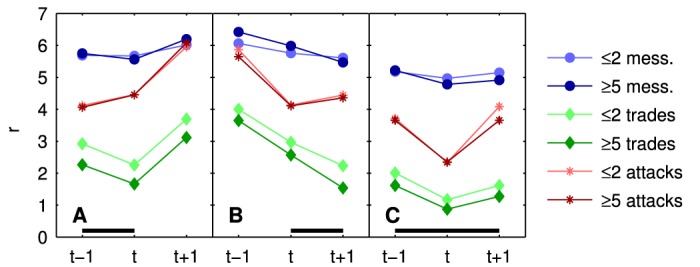
Relative distance r
β of players before and after interactions.The black line indicates the time interval where interactions take place. A the players interact on the first day, but not on the second, B the players interact on the second day, but not on the first, C the players interact on both days.